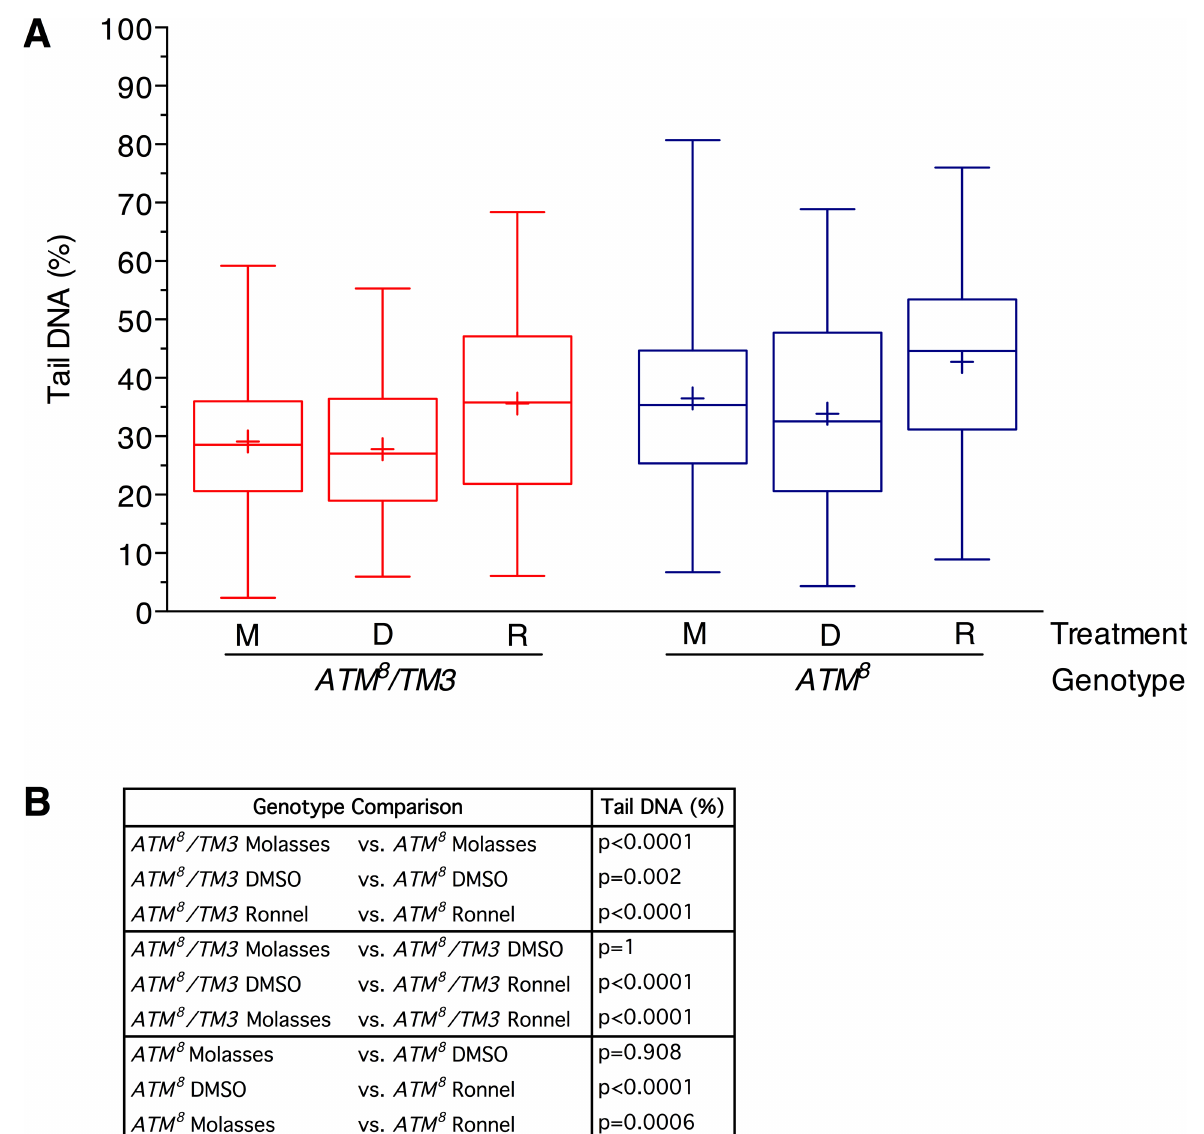
Fig 5. Ronnel increasesthe accumulation of DNA damage in ATM 8 flies. (A) The Comet assay was used to determine the percent tail DNA for brain cells of flies of the indicatedgenotypeand raised on molasses food (M), molasses food with 0.2% DMSO (D), or molasses food with 0.02 mM Ronnelin 0.2% DMSO (R). All data points were graphedusing a box and whisker plot in Prism 7.0 (Graphpad) statistical software. Boxes indicatethe middle50% of the data points, lines in the middleof the boxes indicatethe median, +s in the boxes indicatethe mean, and the maximum and minimum whiskers indicate 95% of the data points (minimum whisker begins at 2.5% and maximum whisker ends at 97.5%). > 200 comets were analyzedfor each condition.(B) P-valuesfor data presentedin panel A were based on an unpairedequal-variance two-tail